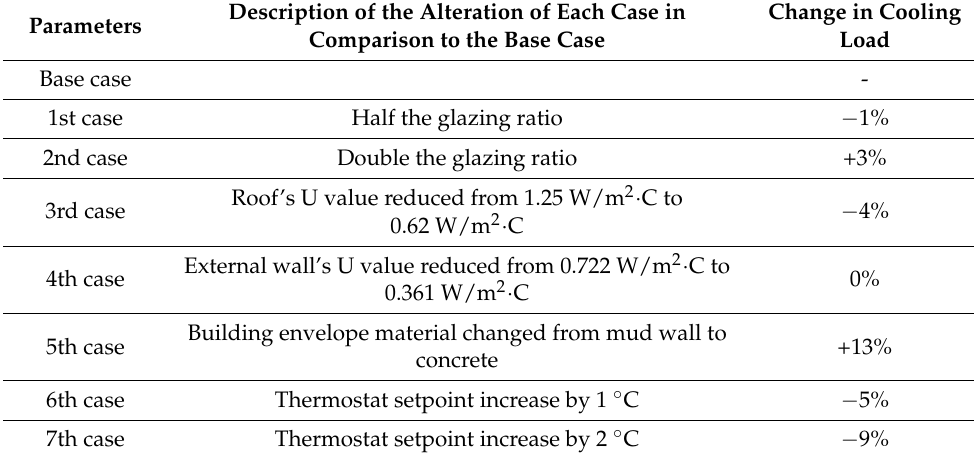
Table 7. Application of improvement cases into Al Wafi Mosque simulation model.